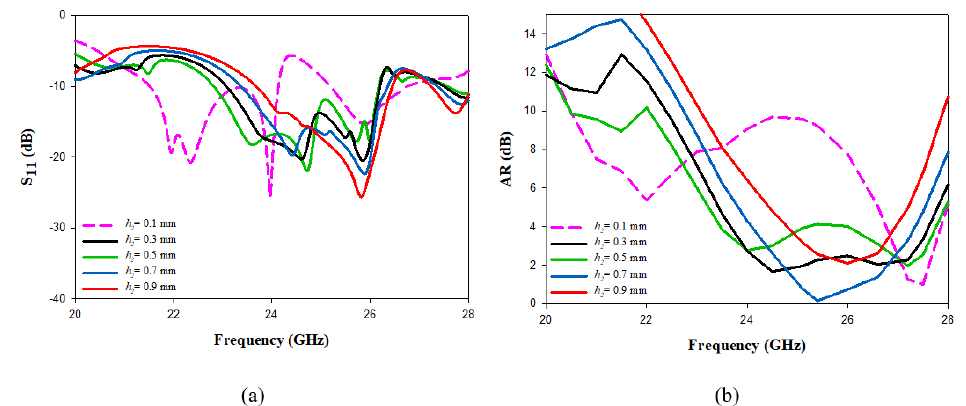
Figure 7. The effect of changing h 2 on ( a ) reflection coefficient ( b ) axial ratio.